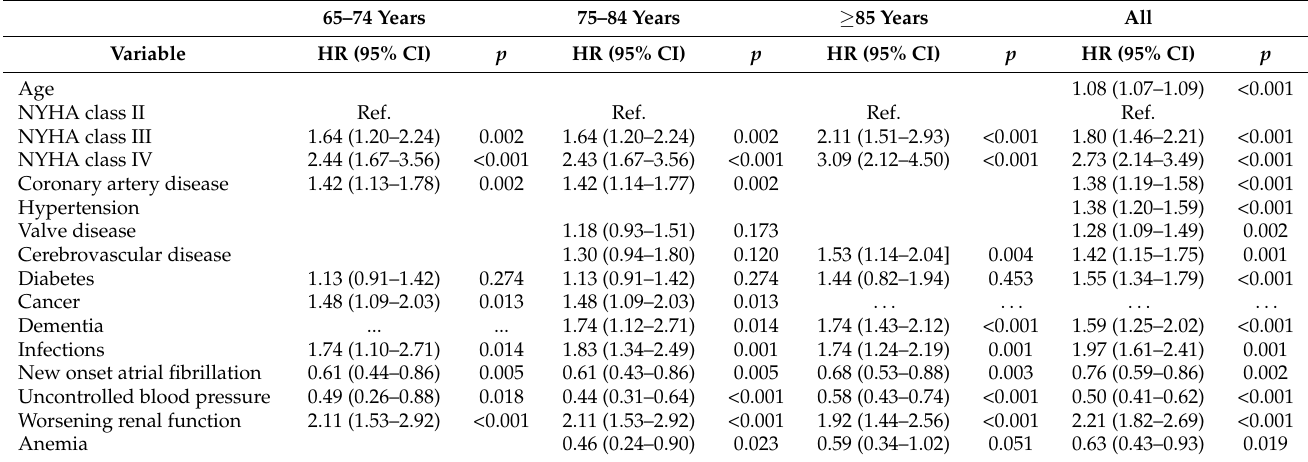
Table 5. Predictors of in-hospital mortality in different age groups (Multivariate